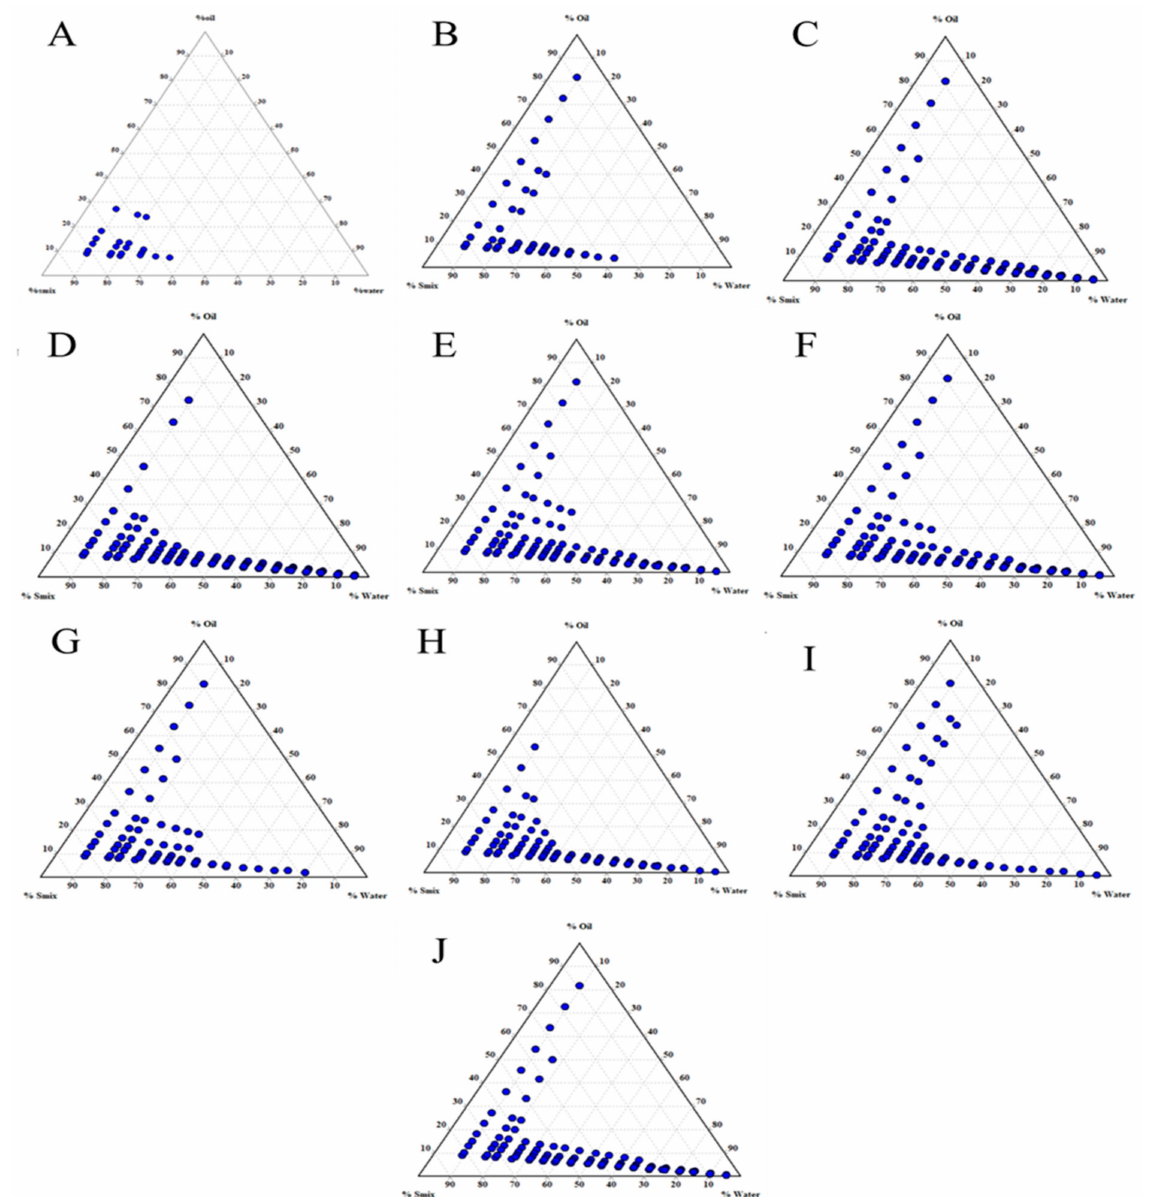
Figure 3. TPDs of nanoemulsions consisting of ethyl oleate and Smix (Tween 20:Labrasol) at Smix ratios of: ( A ) 1:0; ( B ) 1:1; ( C ) 2:1; ( D ) 3:1; ( E ) 4:1; ( F ) 5:1; ( G ) 1:2; ( H ) 1:3; ( I ) 1:4; ( J )